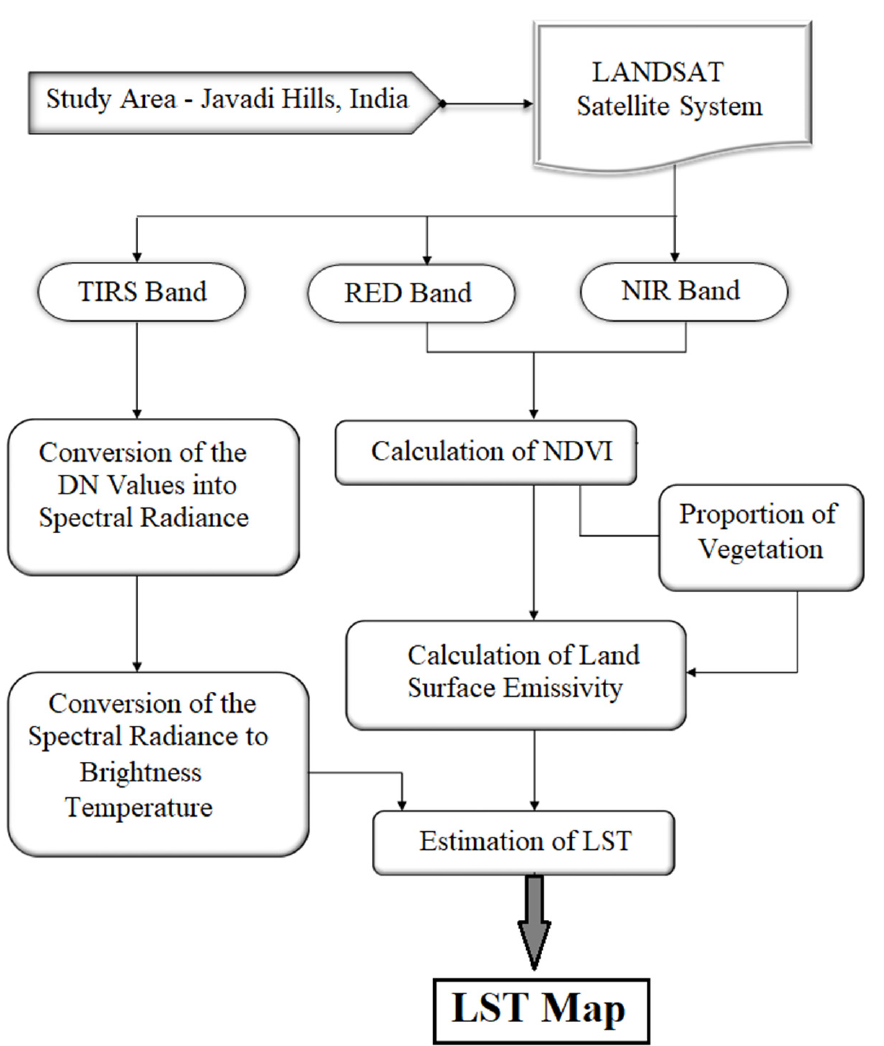
Figure 9. The flow of Land Surface Temperature estimation for the area of Javadi Hills, India.